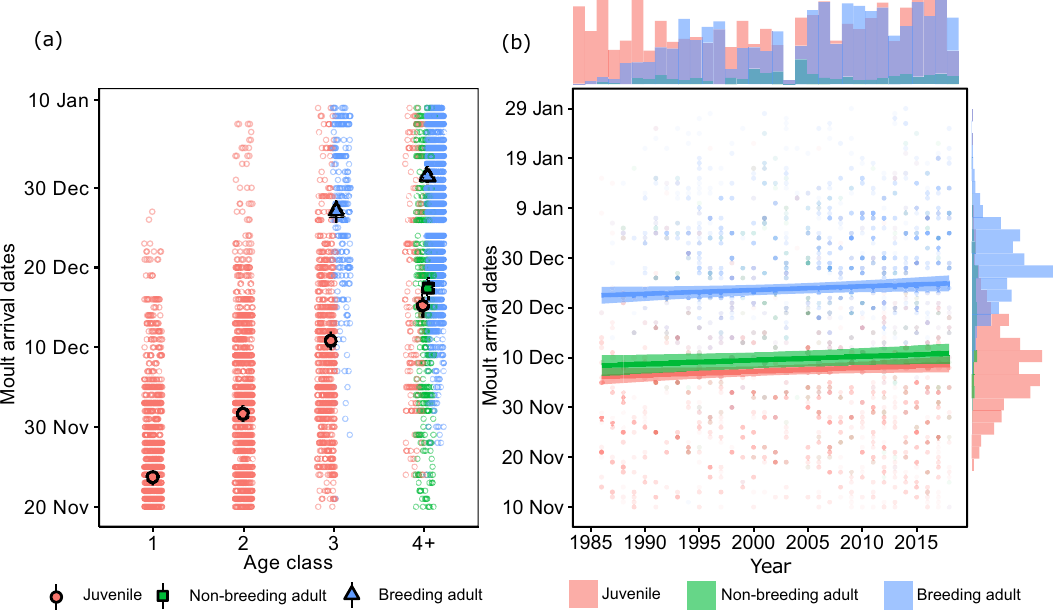
Figure 1. Mean moult arrival dates (and 95% confidence intervals) for female southern elephant seals according to ( a ) age class and breeding state and ( b ) breeding state and time. Estimates were obtained from model 12 (Table 1). Individual data points are plotted on both figures, with the marginal histograms giving the distribution of observations per breeding state.